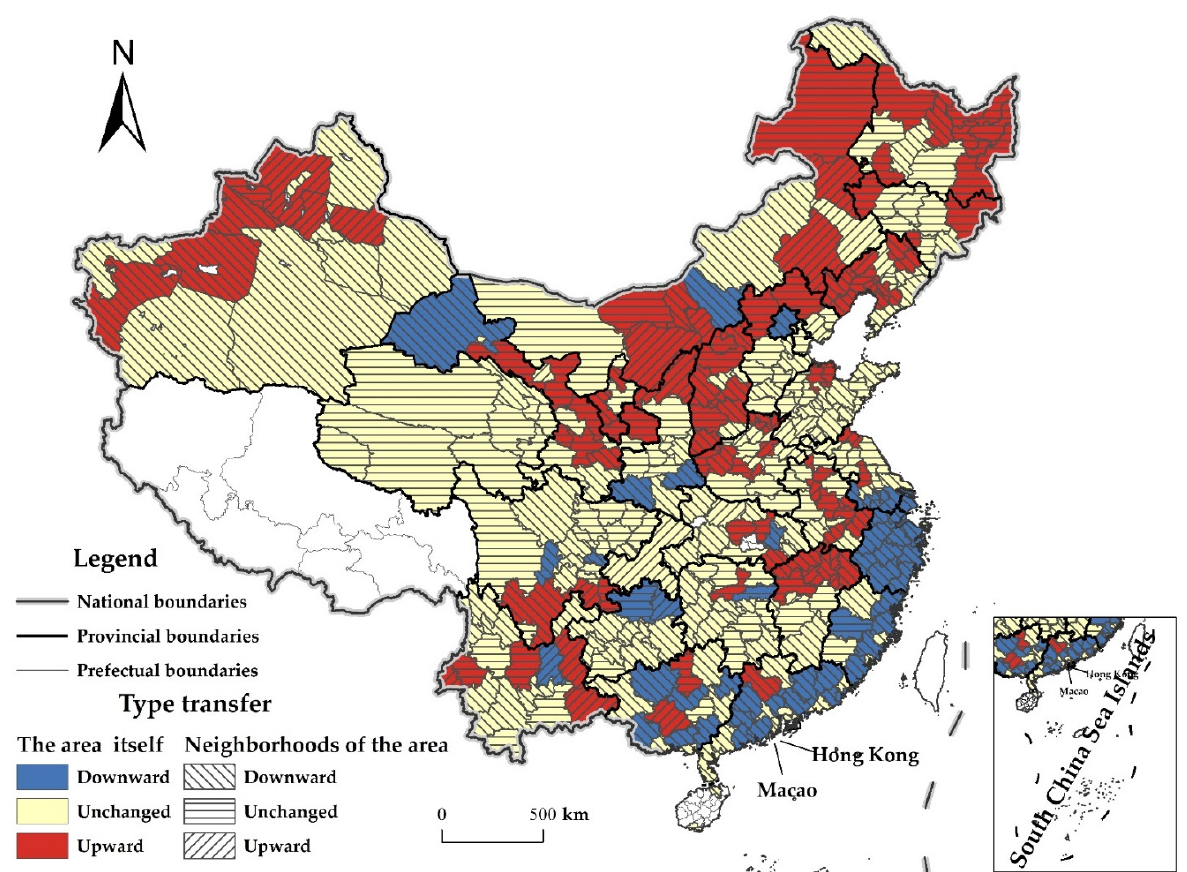
Figure 6. Spatial distribution of CDUFS type of transfer under the spatial Markov chain. Note: This figure is drawn by the authors themselves using ArcGIS based on the calculation results. Table 5. Spatial Chain Transition Probability Matrix for CDUFS.